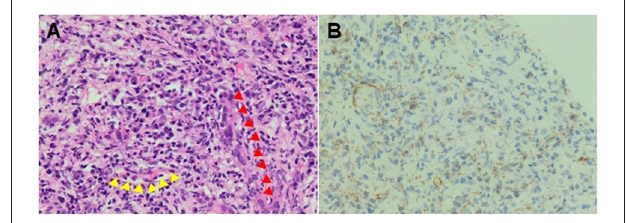
FIGURE 3 | (A) A H&E stain of the liver biopsy (400 X) showing mixed inflammatory infiltrate composed predominantly of lymphocytes and plasma cells and smaller numbers of neutrophils and eosinophils. The bile duct (red arrows) and portal vessel (yellow arrows) are highlighted. (B) An Anti- Treponema pallidum immunohistochemical staining confirmed the presence of spirochetes and highlighted numerous microorganisms having an